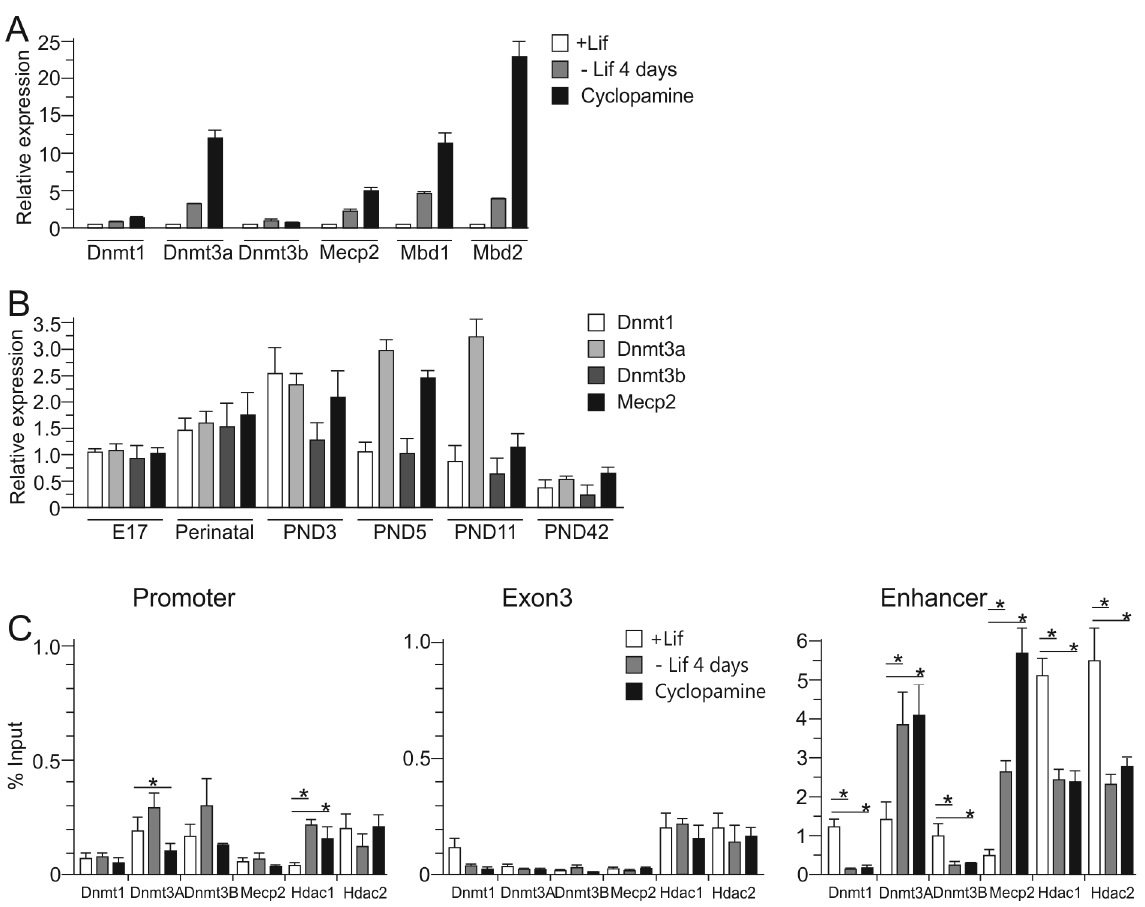
Figure 5. Dnmt3a and Mecp2 associated at the Avp enhancer during differentiation. A, Dnmts, Mecp2 , Mbd1 and Mbd2 mRNA expression during hypothalamic-like differentiation of EB5 cells as evidenced by qRT-PCR analysis. B, Expression of Dnmts and Mecp2 RNAs in the mouse hypothalamus. C, Binding of Dnmts, Mecp2 and Hdacs at the Avp locus during hypothalamic-like differentiation. Chromatin samples from undifferentiated, Lif-withdrawn and further cyclopamine treated EB5 cells were immunoprecipitated with antibodies against Dnmt1, Dnmt3a, Dnmt3b, Mecp2, Hdac1 and Hdac2. Recovered DNA was analyzed by qPCR for the presence of the Avp promoter, gene body or downstream enhancer.